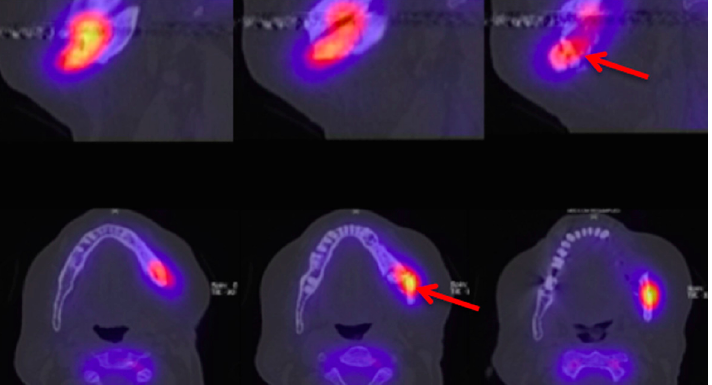
Figure 9. Technetium-99m-3,3-diphosphono-1,2-propanodicarboxylicacid (99Tcm-DPD) SPECT/CT (Siemens, Symbia) Patient: 66 years old, male, secondary osteoporosis due to castration, alendronate. First row sagittal, second row axial view; 4.5 h after injection (bone phase). The uptake in the left mandible is clearly visible ( red arrow). For the panoramic radiograph see Figure 3. AAMOS staging: stage 3.